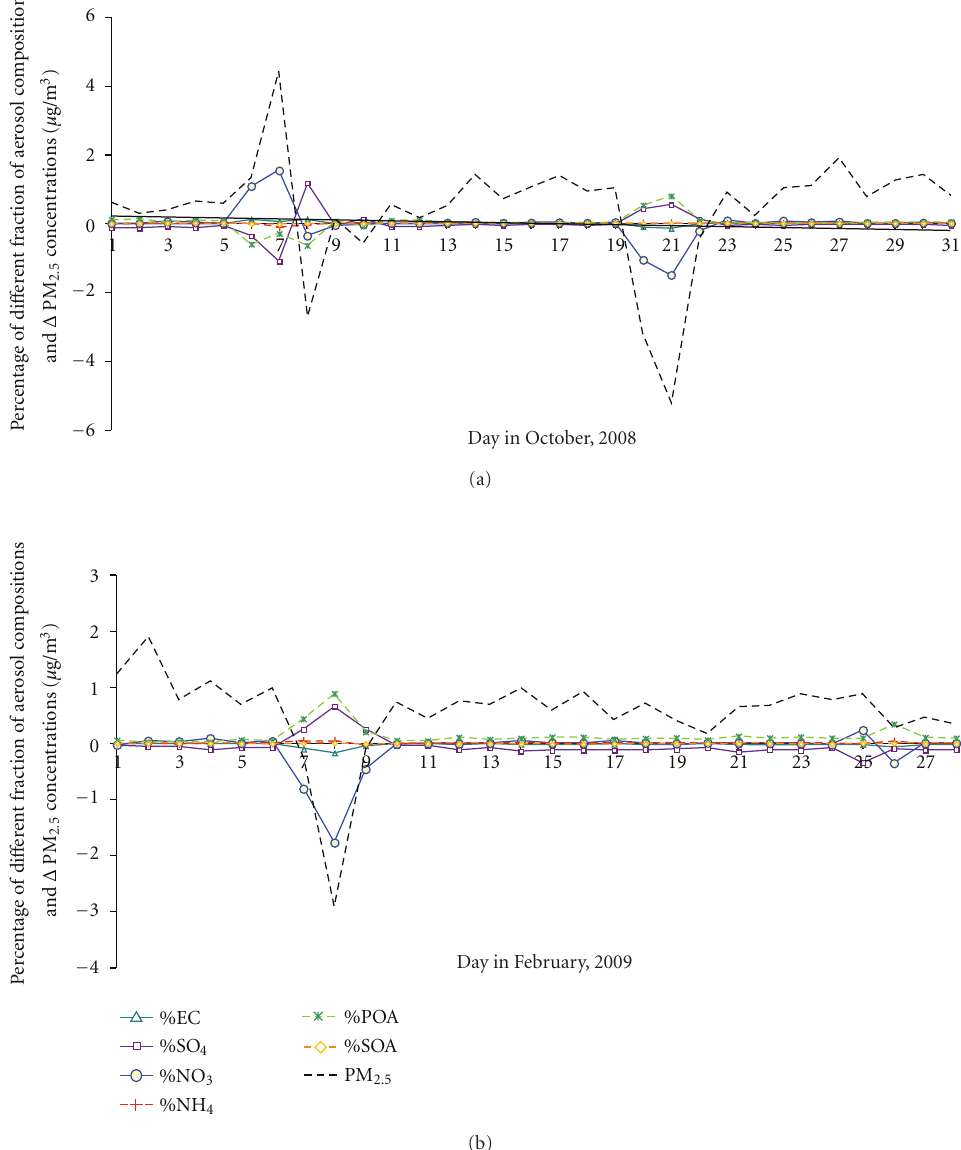
Figure 6: Temporal evolution of daily average percent di ff erences in simulated aerosol compositions in the nonattainment area as obtained for October and